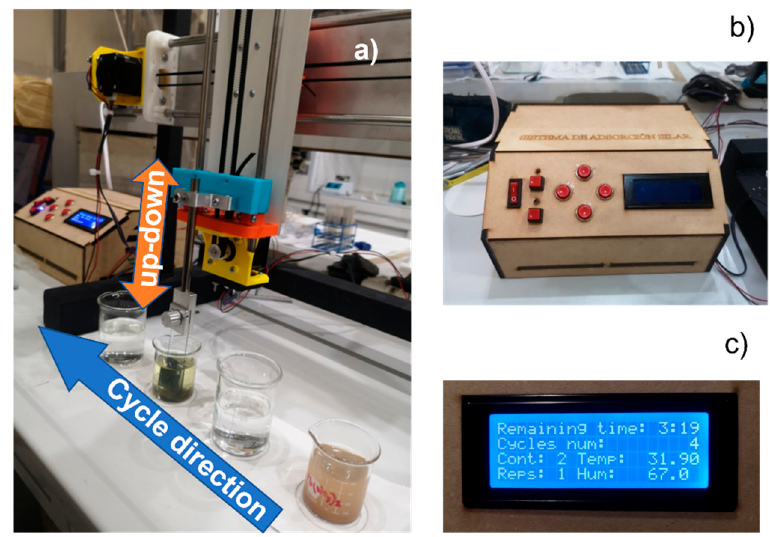
Figure 11. Automated device for thin film deposition by the SILAR method. ( a ) Support structure, moving platform and solution containers, ( b ) control panel console, and ( c ) digital screen of the control panel console.